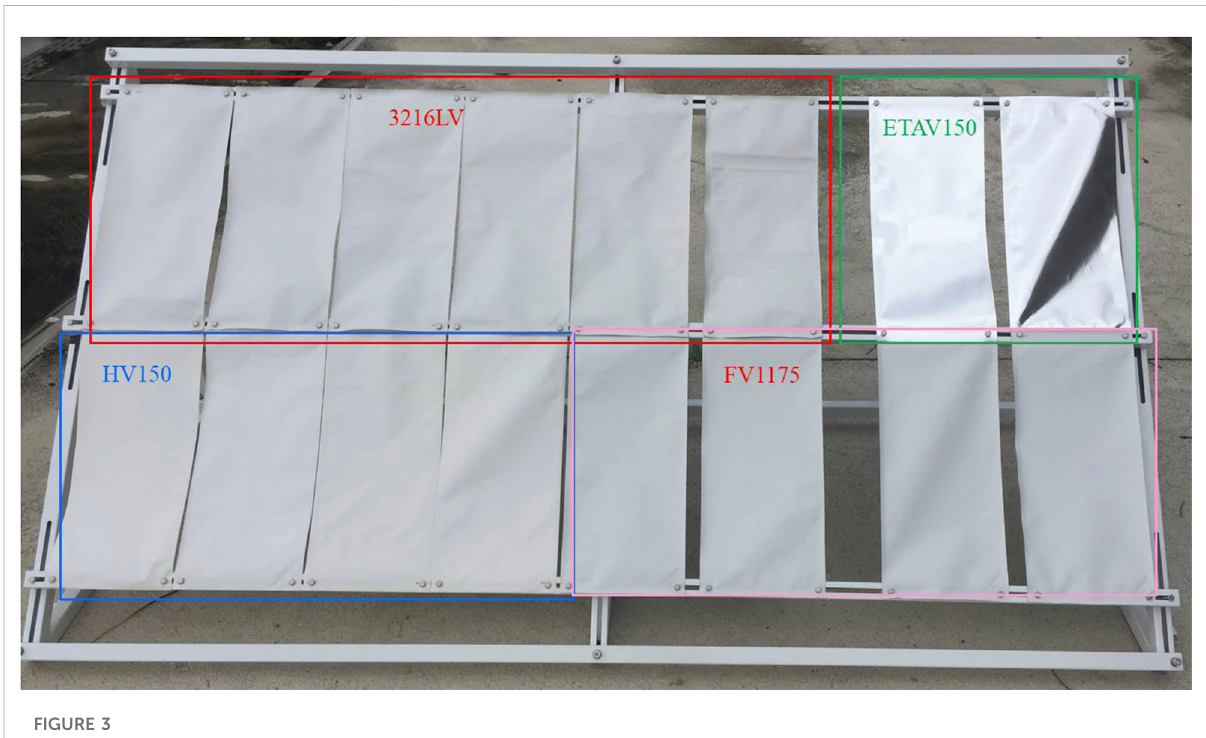
FIGURE 3 Natural aging tests of envelope materials.